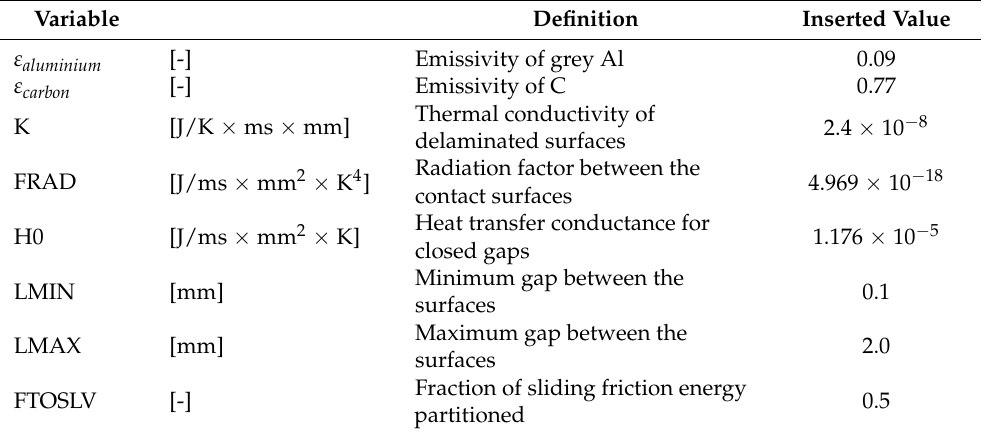
Table 12. Thermal parameters for the global impactor-plate contact algorithm [34,36], based on Equations